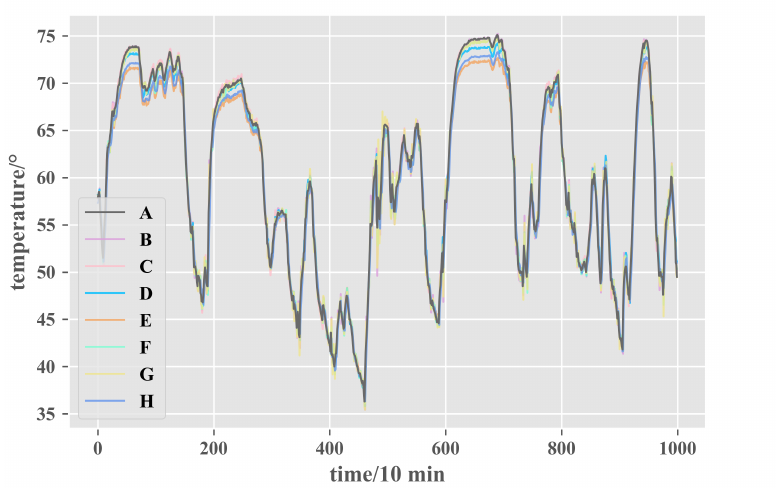
Figure 8. The comparison of different models for gearbox oil temperature prediction in #3.